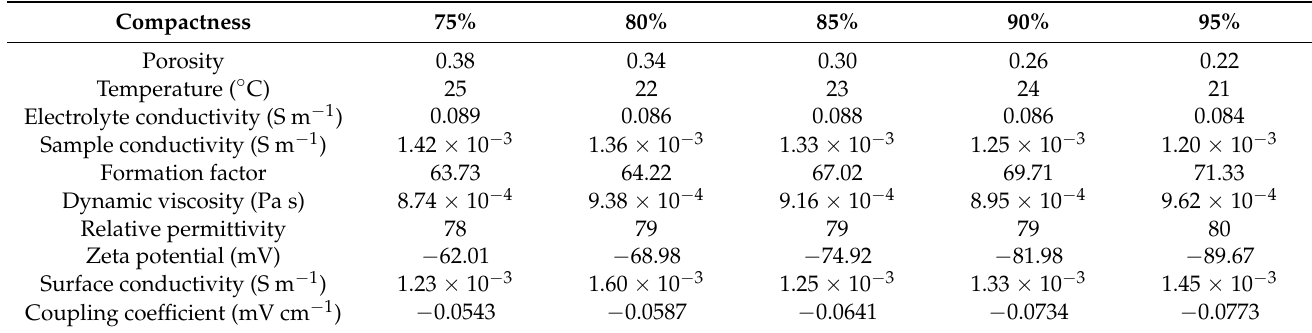
Table 2. Properties of SRM with different compactness.